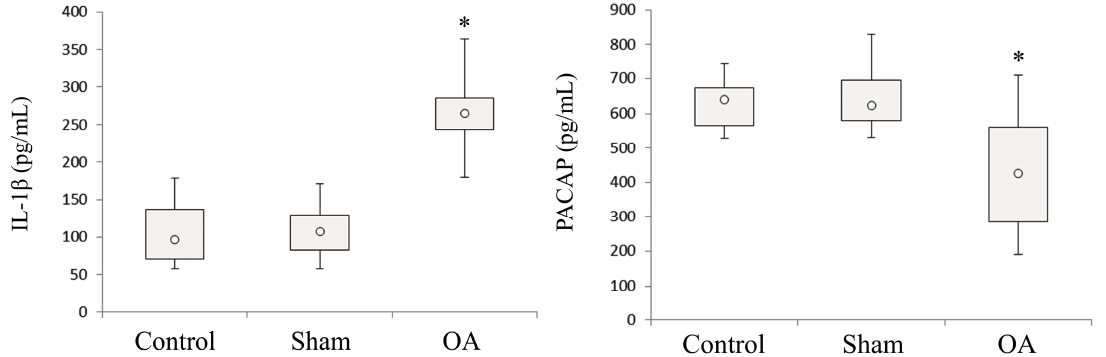
Figure 4. PACAP and IL-1 β concentration in the SF collected from the articular cavity of the knee joint from healthy and ACLT-induced OA rats. PACAP and IL-1 β concentration in the SF was measured by ELISA method both in controls, sham-operated and OA rat groups. The concentration of PACAP and IL-1 β in the box and whisker plots represent the lower and the upper quartile; the open circle in the middle of the box represents the median and the ends of the lines extend to the smallest and largest data point ≤ 1.5 IQR (interquartile range). (* p < 0.05, vs. control and